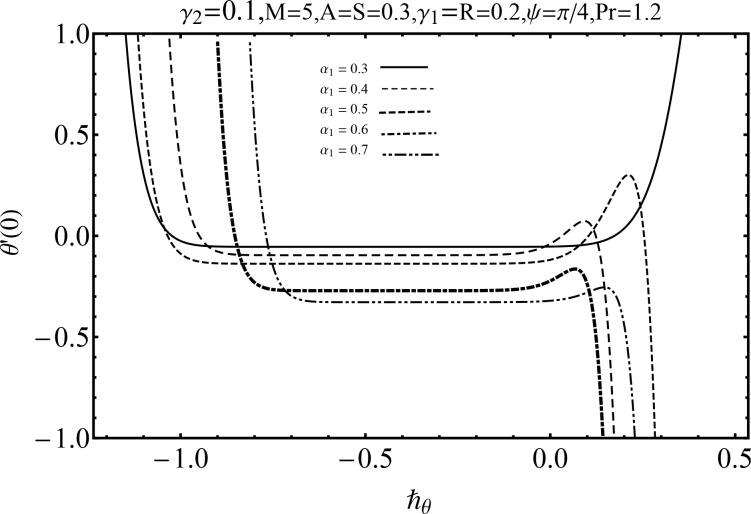
ℏ− curve for θ′(0) via various values of α1.